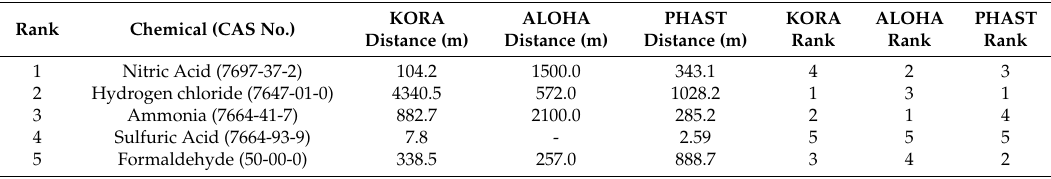
Table 9. A comparison of each modeling program distances in the worst case